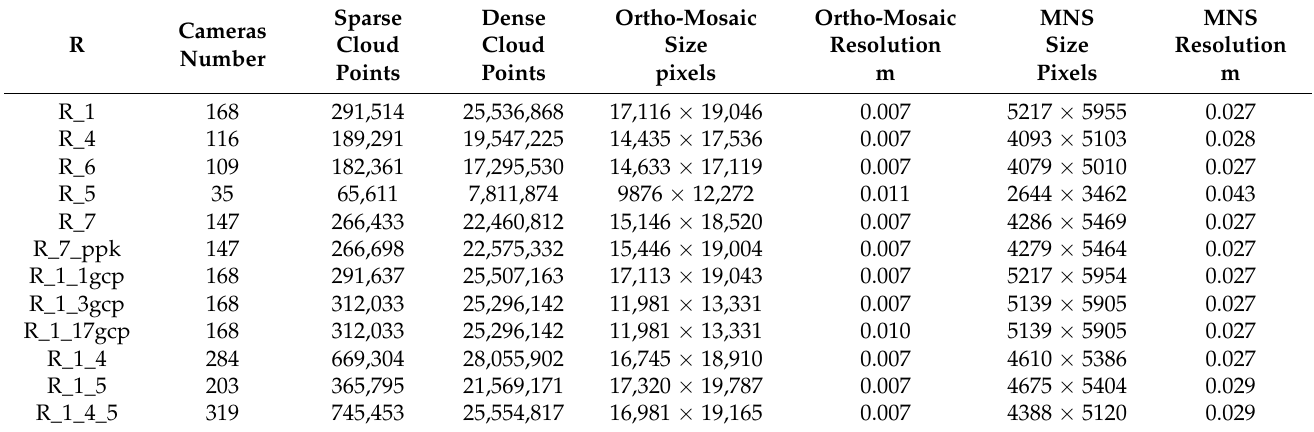
Table 7. The 12 photogrammetric reconstruction output parameters.